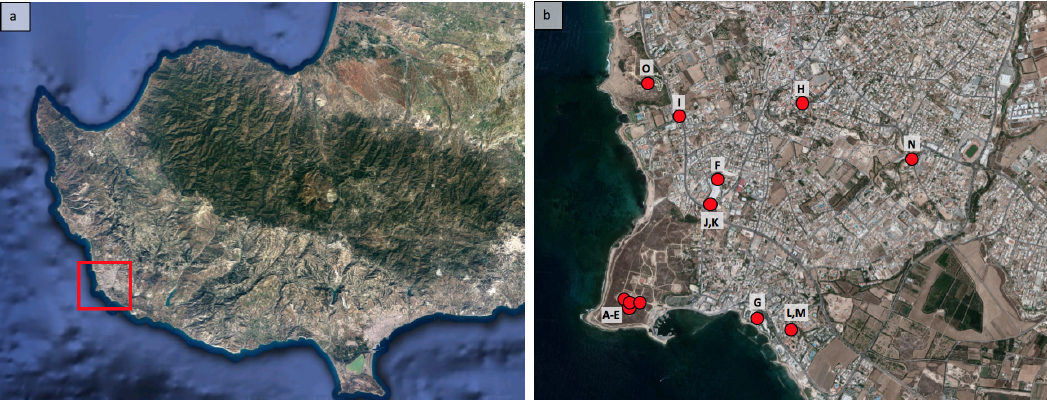
Figure 3. Satellite images: ( a ) satellite map of the southern half of the island of Cyprus, with the region of Nea Paphos highlighted in the red box; ( b ) map of present day Paphos showing the locations of the sites